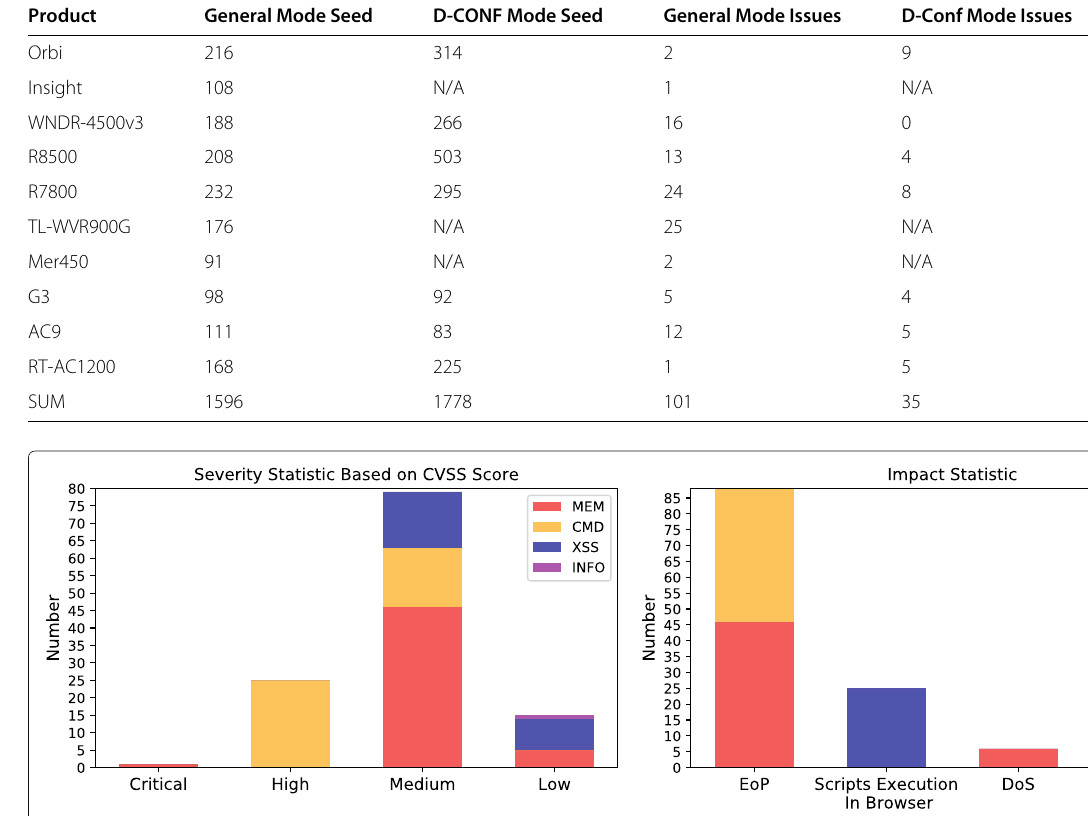
Fig. 8 Topology of the experiment network Table 3 Overall Confirmed Issues of Fuzzing